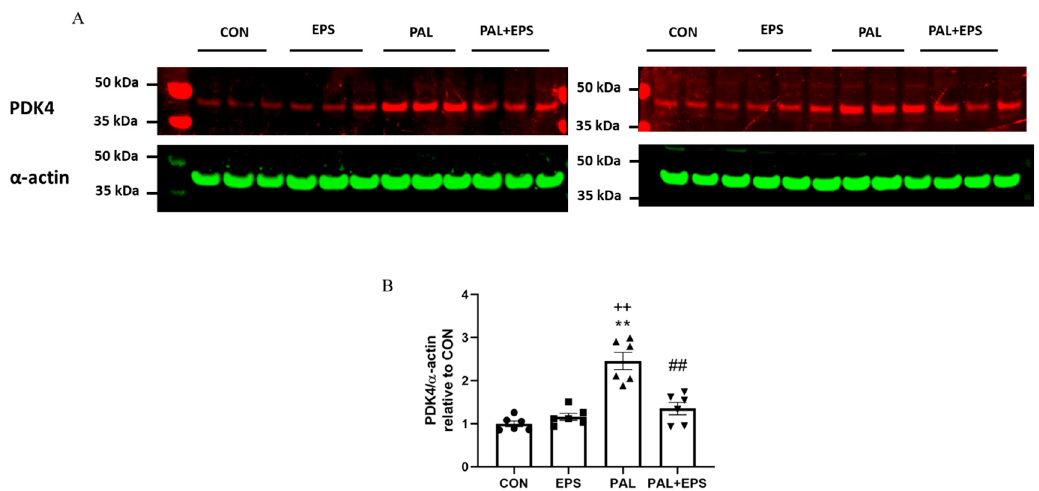
Figure 4. Western blots depicting pyruvate dehydrogenase kinase isoform 4 (PDK4) and α -actin protein bands with their corresponding molecular weights ( A ), their mean band intensities normalised to α -actin ( B ) in C2C12 myotube after exposure to either standard growth media (CON),